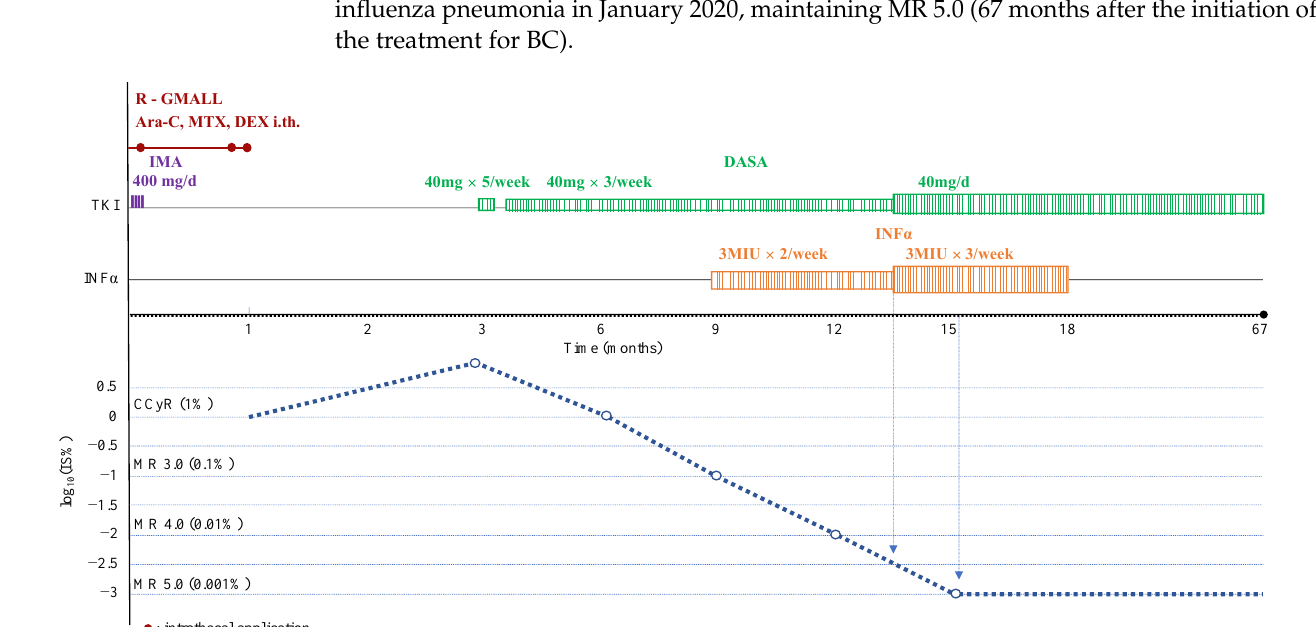
Figure 1. Clinical course of the blast crisis of Patient 1. Abbreviation: R-GMALL, rituximab-German multicentre acute lymphoblastic leukaemia protocol; Ara-C, cytosine arabinosine; MTX, methotrexate; DEX, dexamethasone; i.th., intrathecal; IMA, imatinib; DASA, dasatinib; TKI, tyrosine kinase inhibitor; INF α , interferon α ; CCyR, complete cytogenetic response; MR, molecular response.